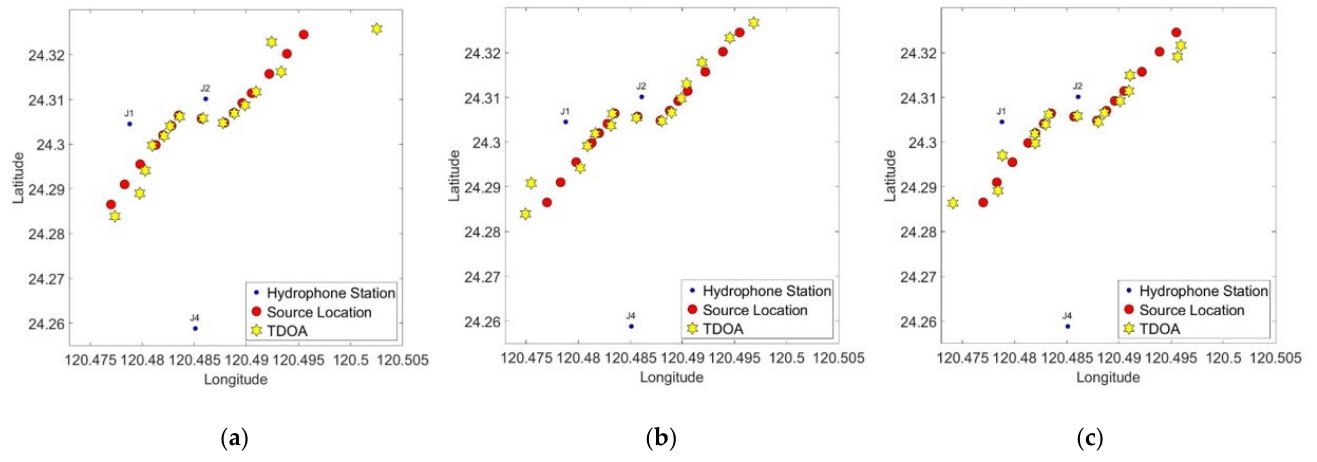
Figure 10. ( a ) Result of rising frequency signal; ( b ) result of decreasing frequency signal; ( c ) result of U-shaped signal.